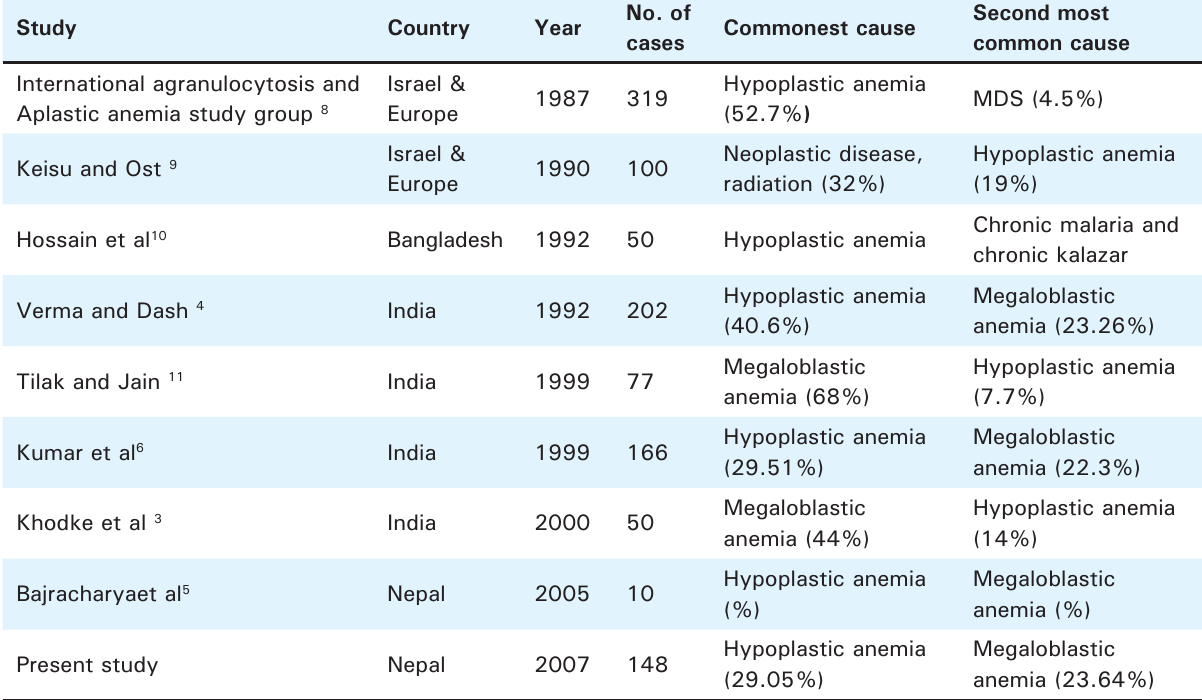
Table 6. A comparison of the fi rst and second most common causes of pancytopenia in different studies